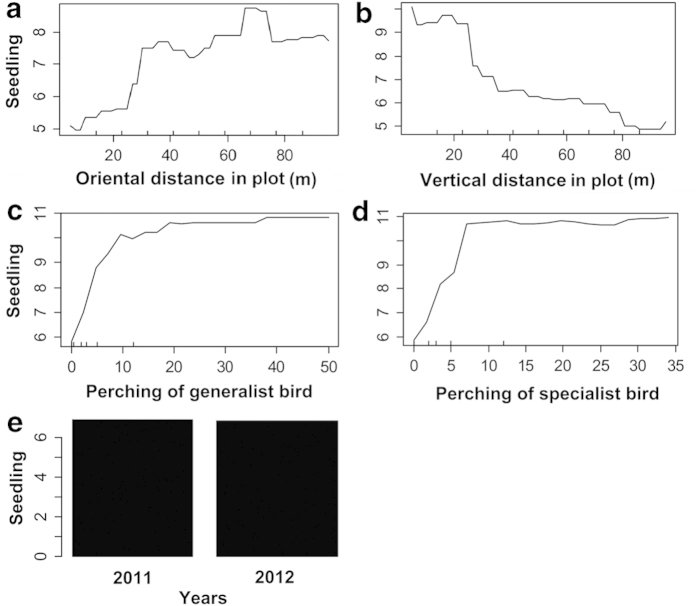
A machine learning algorithm, random forest, for testing the association between the number of seedlings and plot (a, b), bird perching frequency (c, d), and years (e) in the patchy habitat of yew ecological garden, Fujian province. (a) relationship between seedling and oriental distance in plot; (b) relationship between seedling and vertical distance in plot; (c) relationship between seedling and perching of Red-billed blue magpie Urocissa erythrorhyncha; (d) relationship between seedling and perching of Black Bulbul Hypsipetes leucocephalus; (e) relationship between seedling and Sampling years.